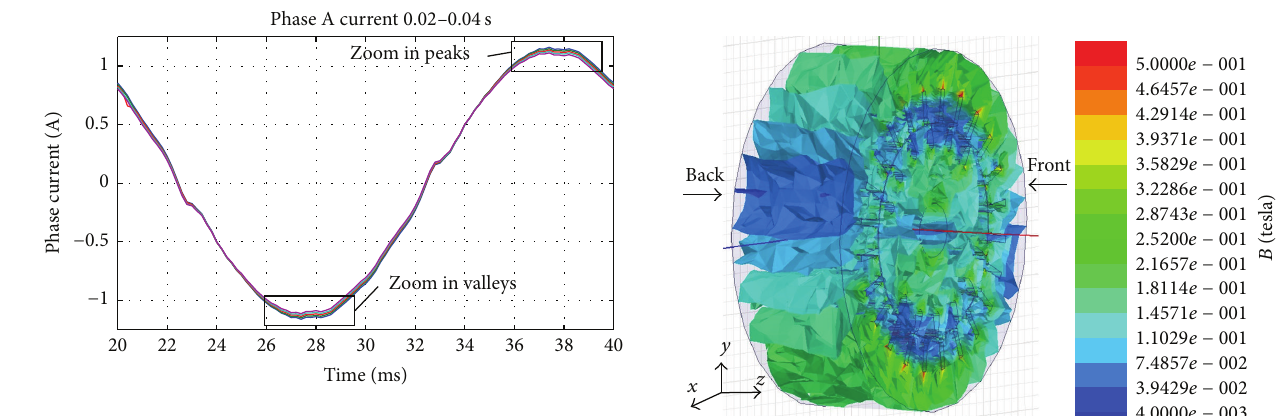
Figure 14: Relationship between axial displacement and stator phase current (Phase A).